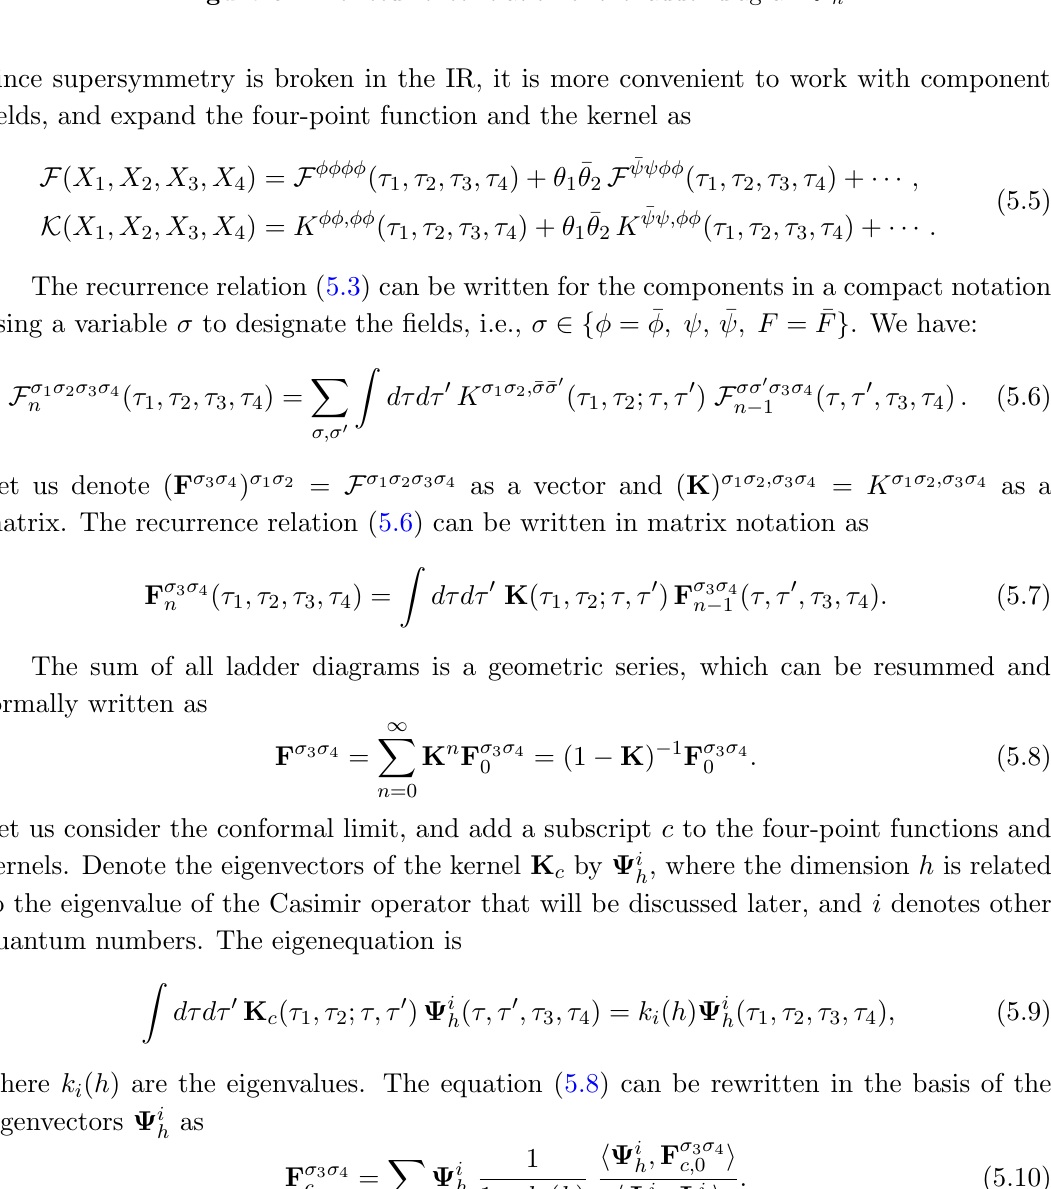
Figure 6. The recurrence relation of the ladder diagram F n